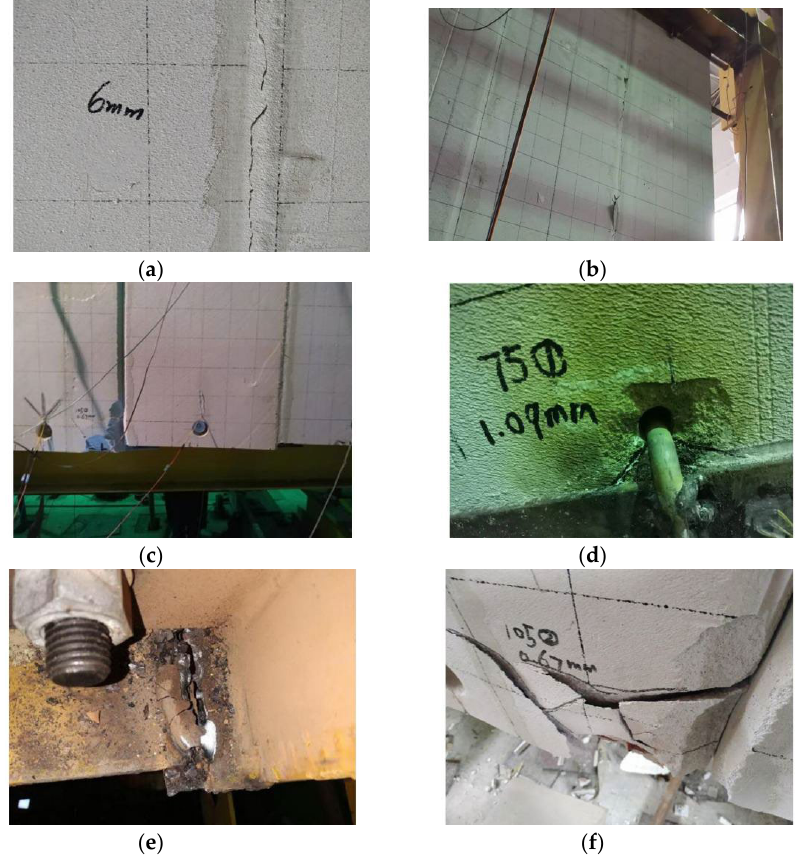
Figure 10. Test phenomenon of DC. ( a ) Adhesive mortar cracking. ( b ) Adhesive mortar falling off. ( c ) Dislocation between panels. ( d ) A splayed crack. ( e ) The weld seam cracked at beam-column welding. ( f ) Concrete at the corner of ALC panels was crushed.